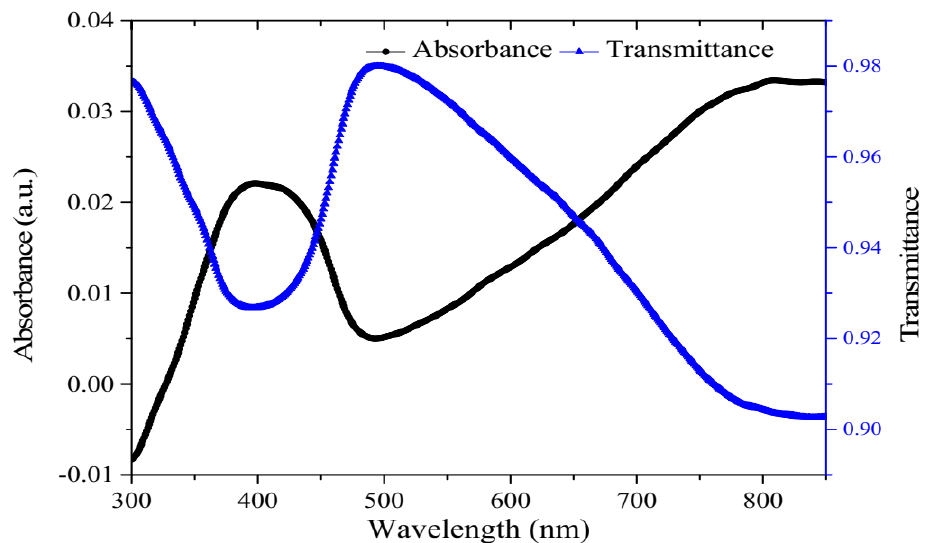
Figure 2. UV-Vis absorption and transmittance spectra vs. the wavelength of the ternary composite film prepared using NMP